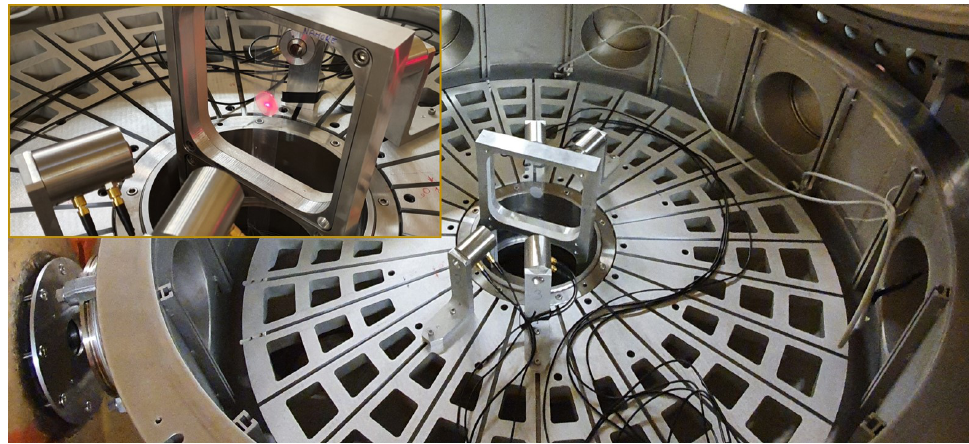
Figure 2. The photography of the internal set-up of the CLID placed behind the